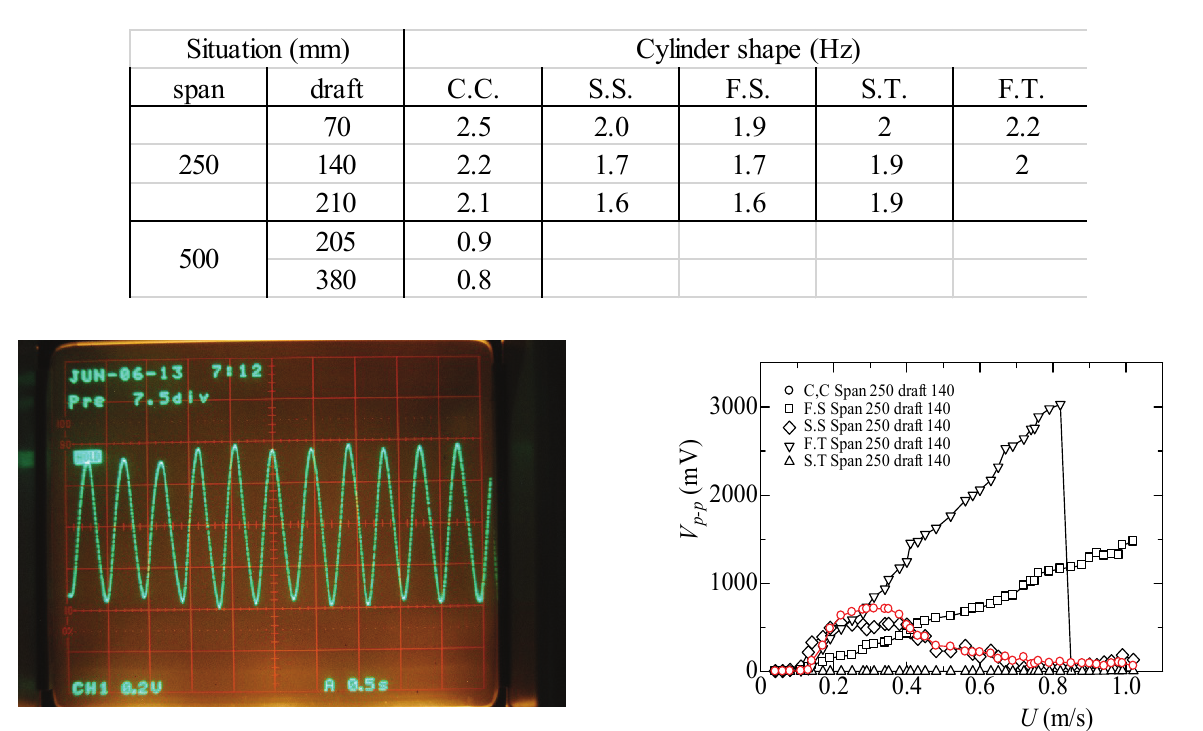
Tab. 1. Synthetic character frequency of the test cylinder